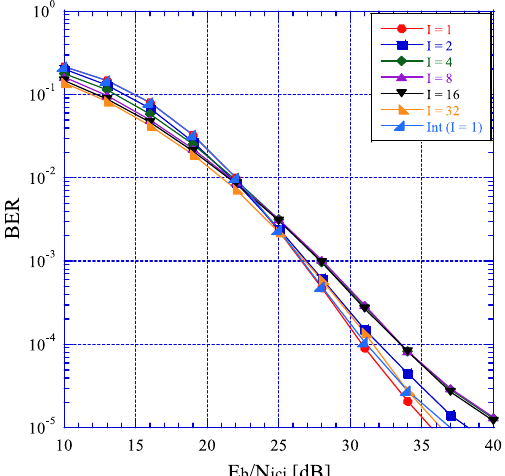
Fig. 15 BER of the various E b / N ici for the power combination with the DFT and the MMSE, without the coding at E b / N 0 = 25